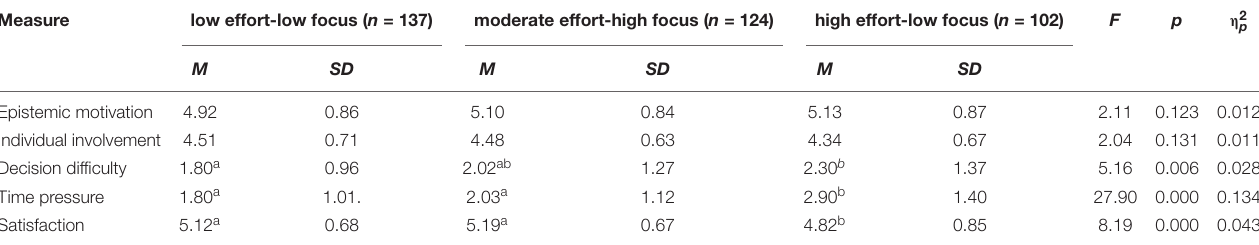
TABLE 7 | Means, Standard Deviations and Results of the ANOVA’s on the Additional Psychological Variables. Measure low effort-low focus ( n = 137) moderate effort-high focus ( n = 124) high effort-low focus ( n = 102) F p η 2 p M SD M M SD